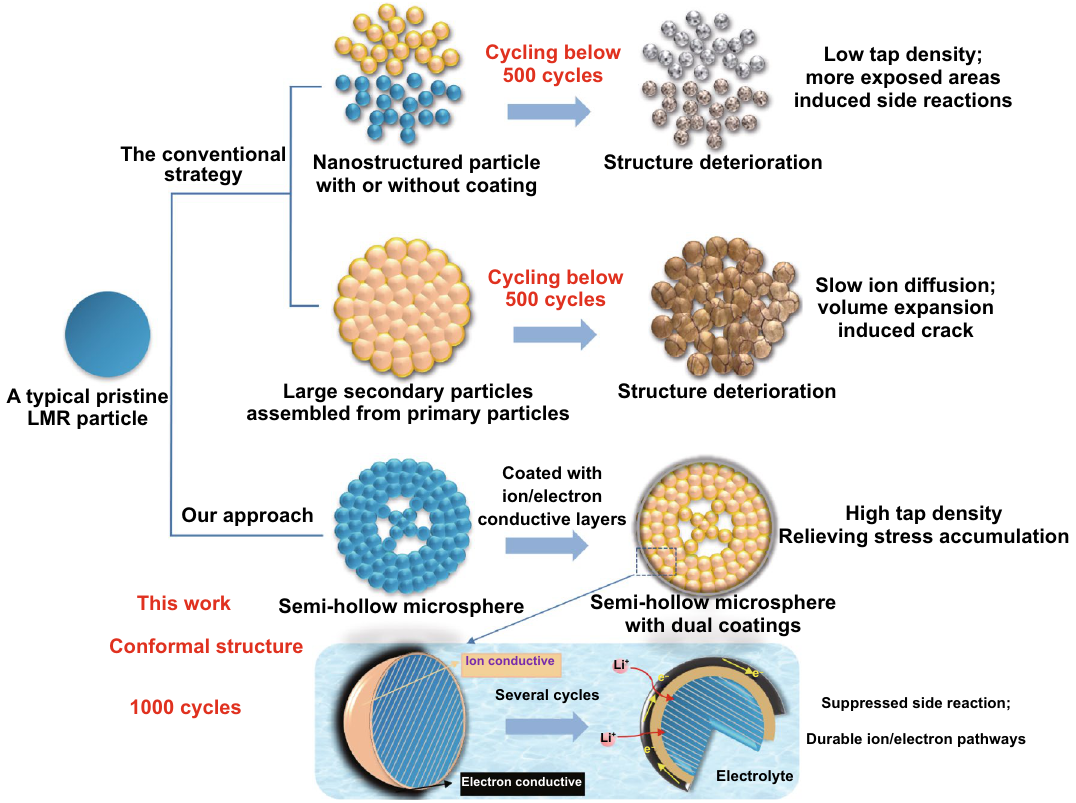
Fig. 1 Schematic illustration of highlighting the high-conformal structure of the LMR particle. Compared with nanostructured or densely assembled LMR particle that may still suffer structure degradation, integrated advantages enabled by bifunctional strategy can be